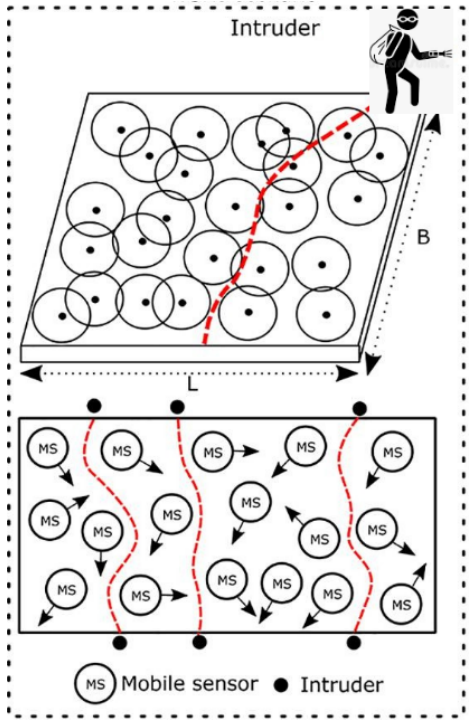
Figure 1. Example of sensors for identifying